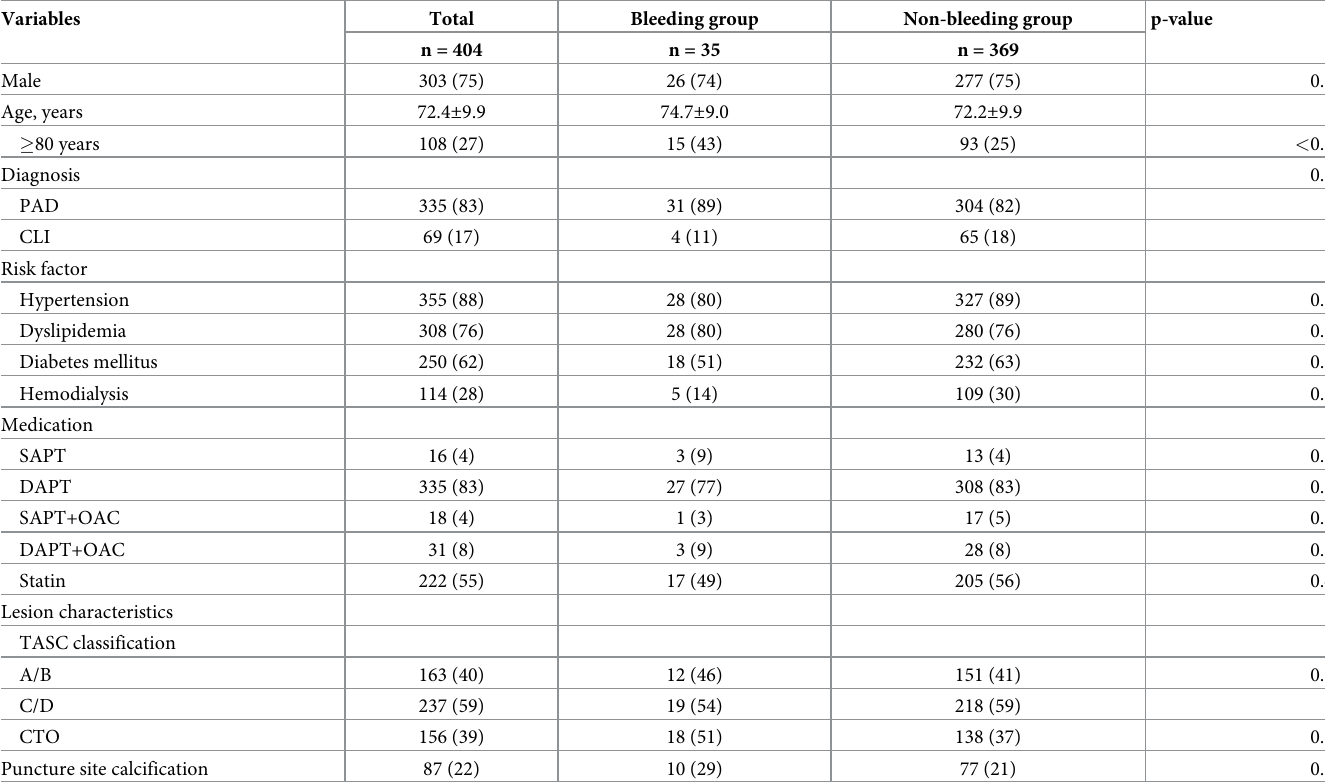
Table 1. Patients’